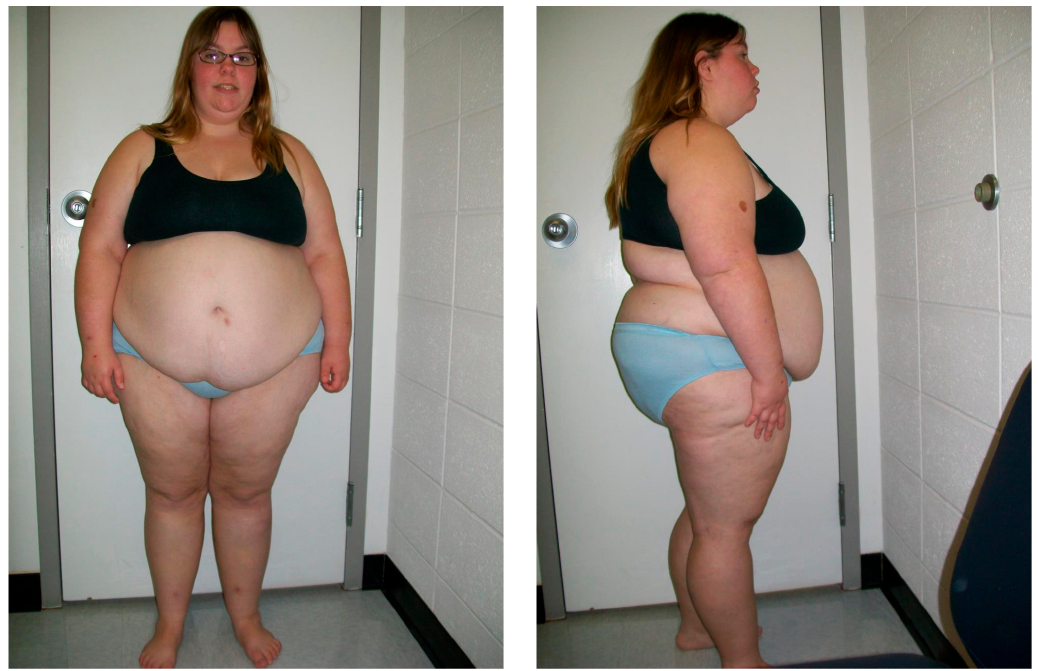
Figure 1. Frontal and profile views of a 16-year-old female with Prader–Willi syndrome due to maternal disomy 15, showing the classical features observed in this obesity-related